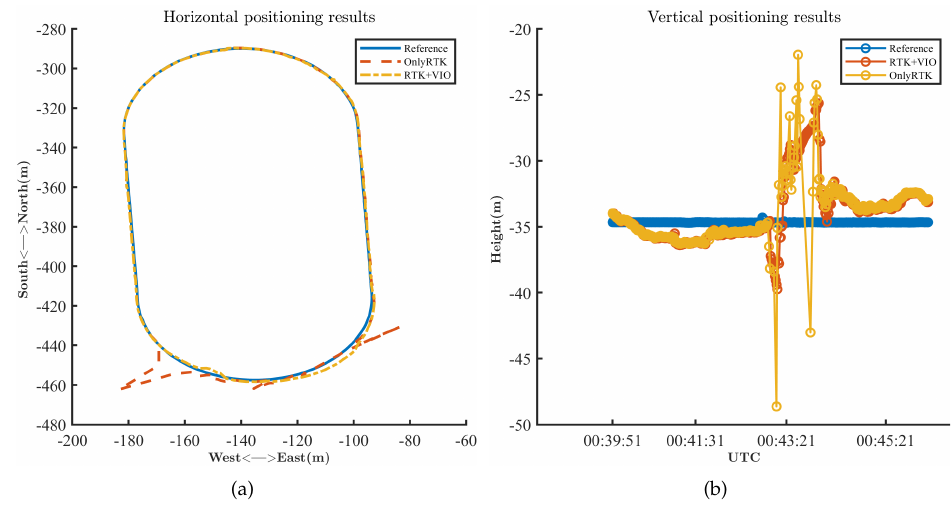
Figure 14. The performance of the integration of real-time kinematic (RTK) technique and VIO. ( a ) Horizontal positioning results. ( b ) Vertical positioning results.